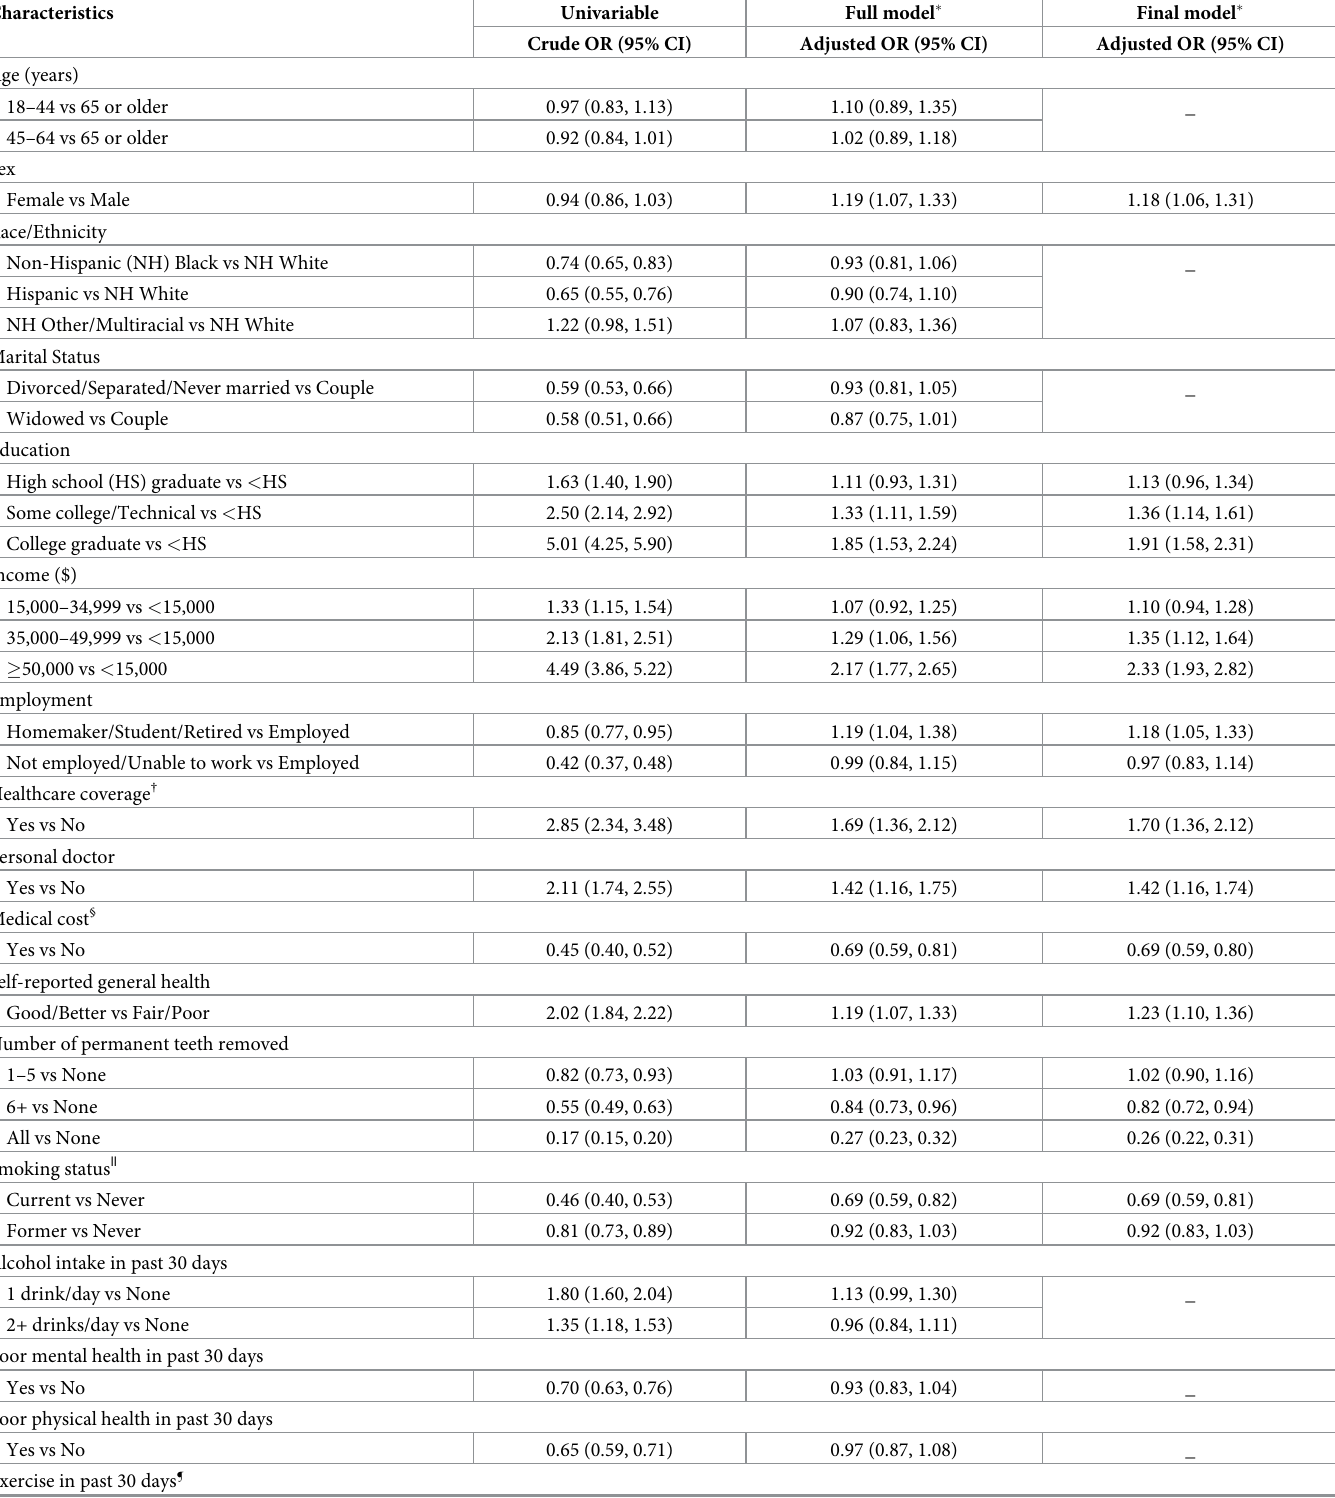
Table 2. Crude and adjusted odds ratios (OR) for dental visit compliance by participants’ characteristics (n = 40,585; N = 19,281,982).